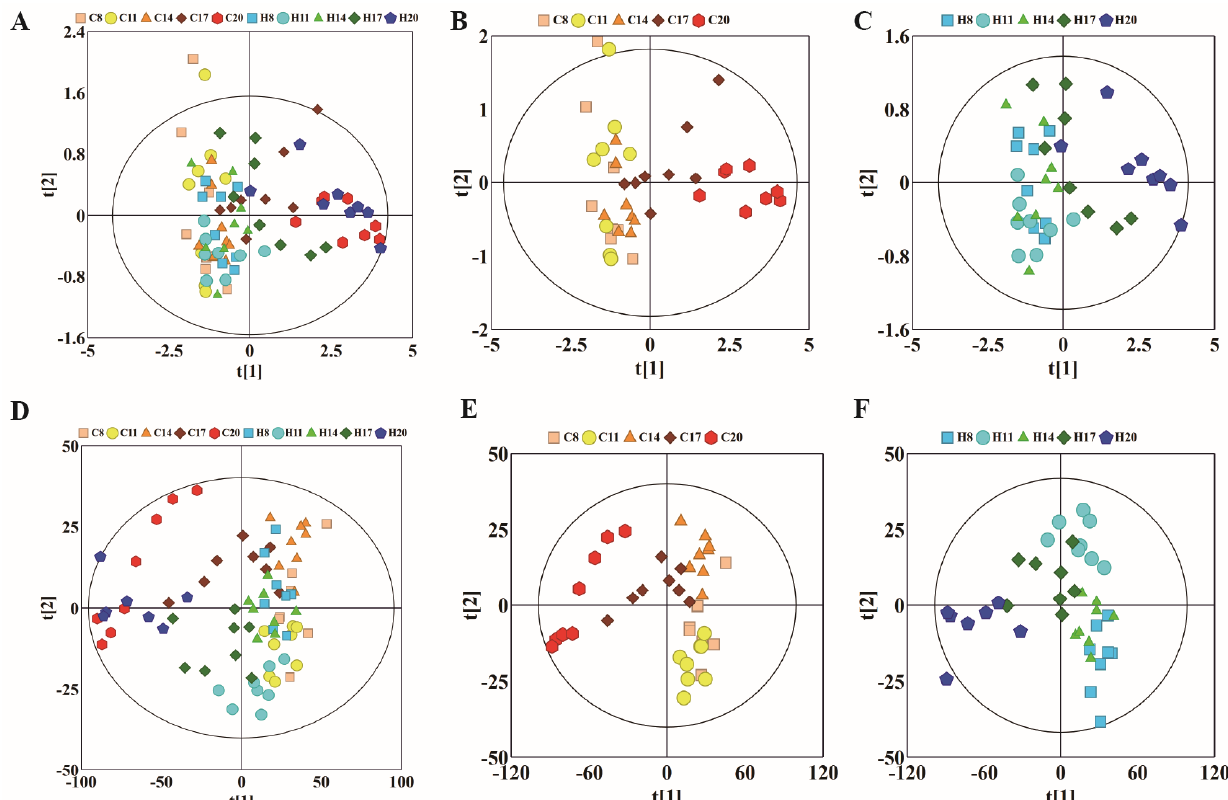
Figure 2. PCA and corresponding PLS-DA score plots derived from 1 H NMR spectra of plasma samples obtained from different groups at different gestation period. ( A ) PCA score plots of control group and hypoxia group; ( B ) PCA score plots of control group; ( C ) PCA score plots of hypoxia group. ( D – F ) corresponding PLS-DA score plots of ( A – C ). (C: control group; H: hypoxia